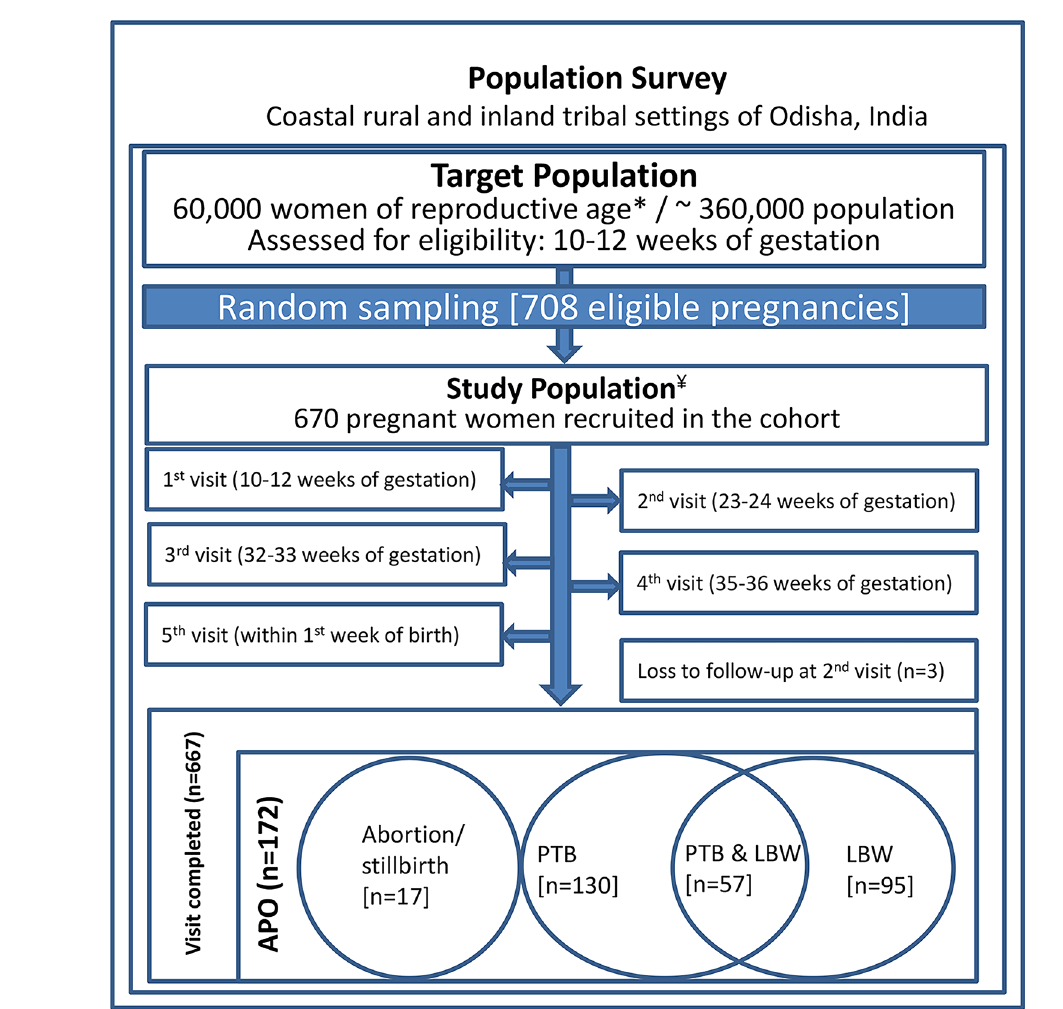
Fig 1. Study design and sampling